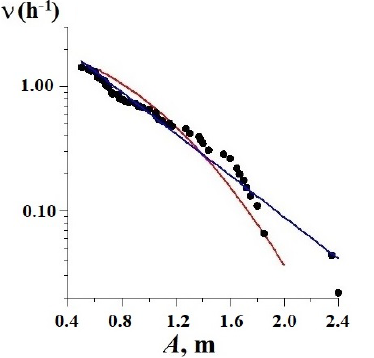
Figure 1. The exceedance frequency of internal wave amplitudes in the eastern part of the Mediterranean Sea.